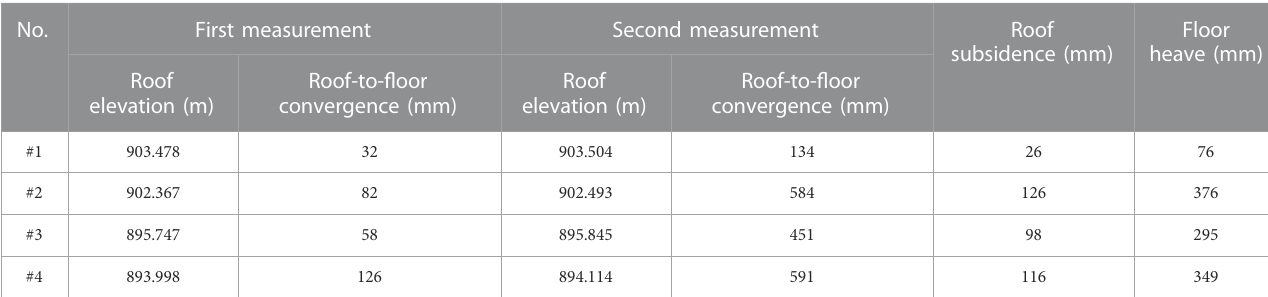
TABLE 1 Point elevation